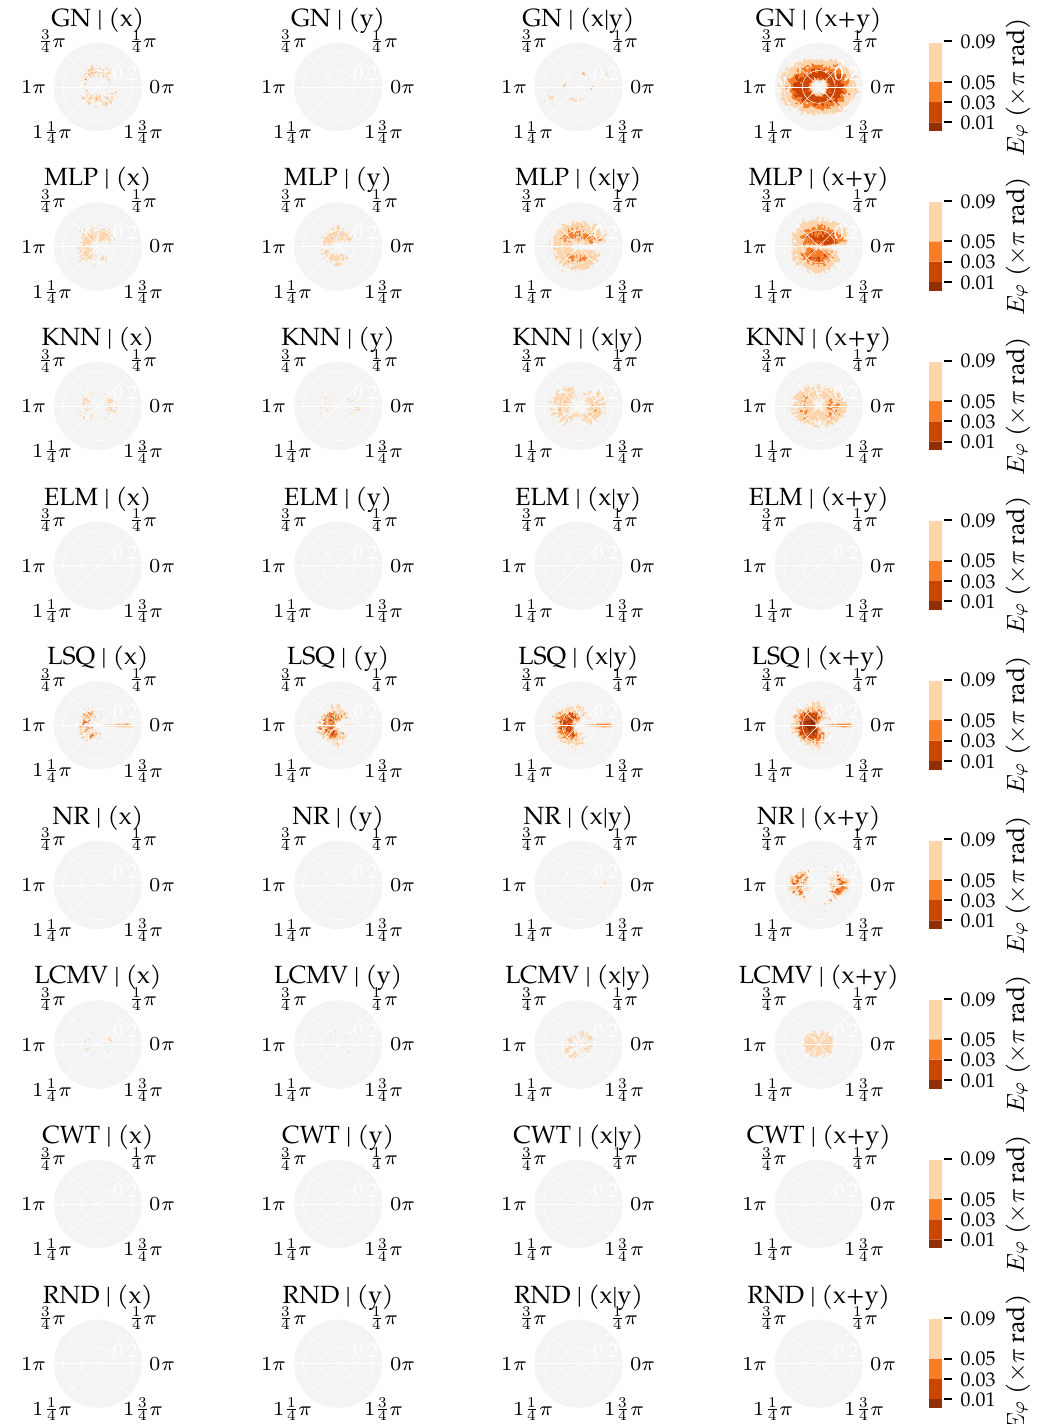
Figure A11. Polar contours of the median movement direction error (Equation (5)) for each localisation algorithm in all conditions of Analysis Method 2. These figures indicate how the movement direction ϕ and distance d of a source influence the error. This analysis varied the sensitivity axes of the sensors: (x + y) measured both velocity components at all sensors, (x|y) alternated measuring v x and v y for subsequent sensors, (x) measured only v x at all sensors, (y) measured only v y at all sensors. The D s = 0.01 training and optimisation set and σ = 1.0 × 10 − 5 ms − 1 noise level were used. The median movement direction error was computed in 2 × 2 cm 2 cells. The sensors were equidistantly placed between x = ± 0.2